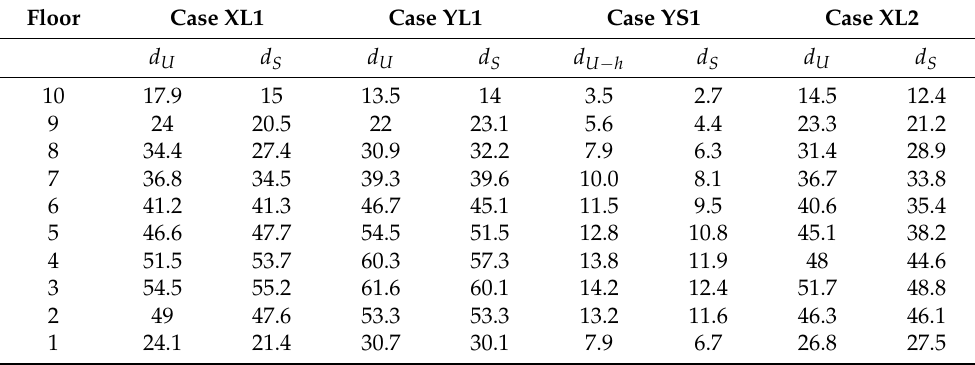
Figure 11. Inter-story displacement time history of case XL1.